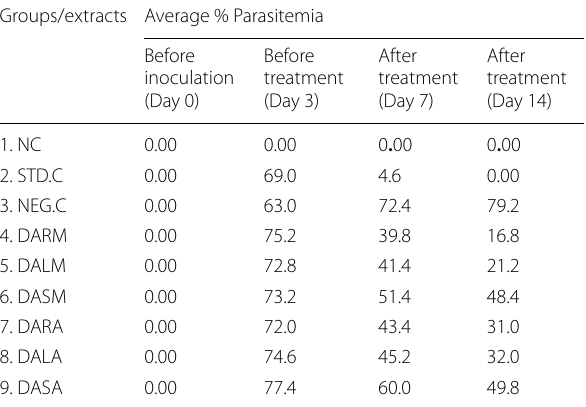
Table 5 Activities of crude aqueous and methanolic extracts of roots, leaves and stem of D. arborescens on percentage parasitemia of Plasmodium berghei infected male Swiss albino mice